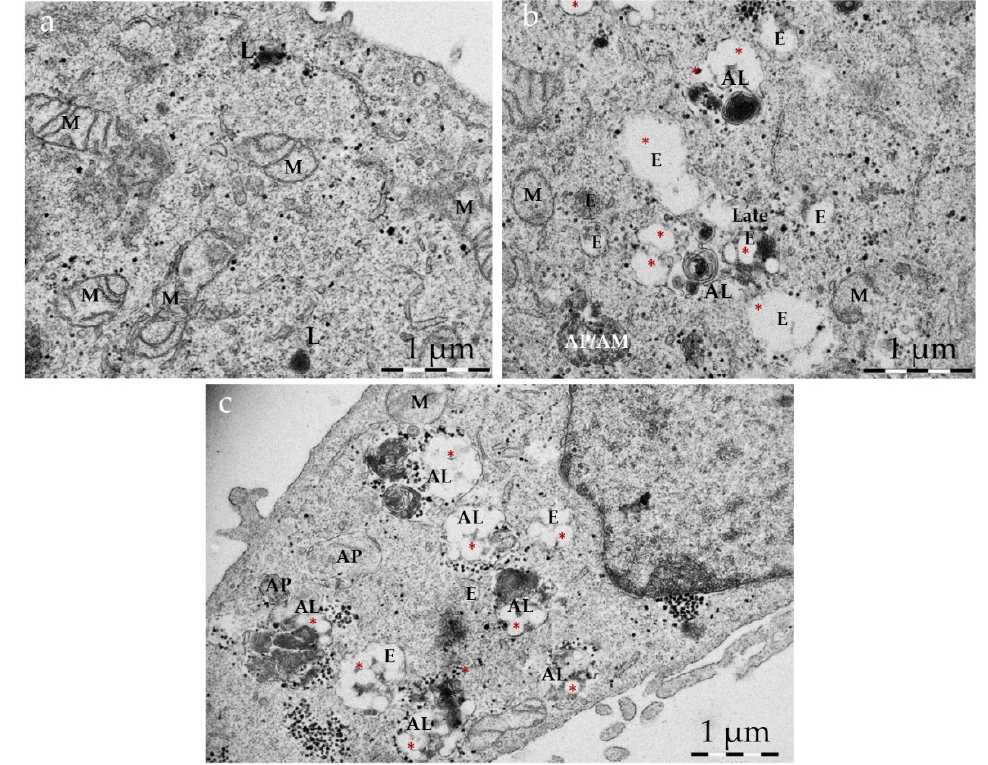
Figure 5. Intracellular accumulation of NP T-B and autophagic compartments. Representative TEM images of HeLa cells: untreated ( a ), treated with NP T-B (2 µM) ( b ) or NP T-B (2 µM) for a total of 43 h and bafilomycin A (50 nM) added at the last 2–3 h of co-incubation ( c ). At basal conditions ( a ), autophagic vacuoles were scarce but a few lysosomes (L) were present. Many endosomal compart- ments and some autophagosomes (AP) with a double membrane containing cytoplasmic cargo were observed in NP-T-B treated cells ( b , c ). Co-treatment with bafilomycin ( c ) resulted in a greater accu- mulation of autophagic compartments in NP T-B co-treated samples. NPs (denoted with red aster- isks) were observed in endosomal (E), endolysosomal (EL) and autolysosomal (AL) compartments ( b , c ). Images are representative of at least 50 images for each treatment condition. AL: autolysosome; E: endosome; EL: endolysosome; L: lysosome; M: mitochondrion. Scale bar: 1 µm.